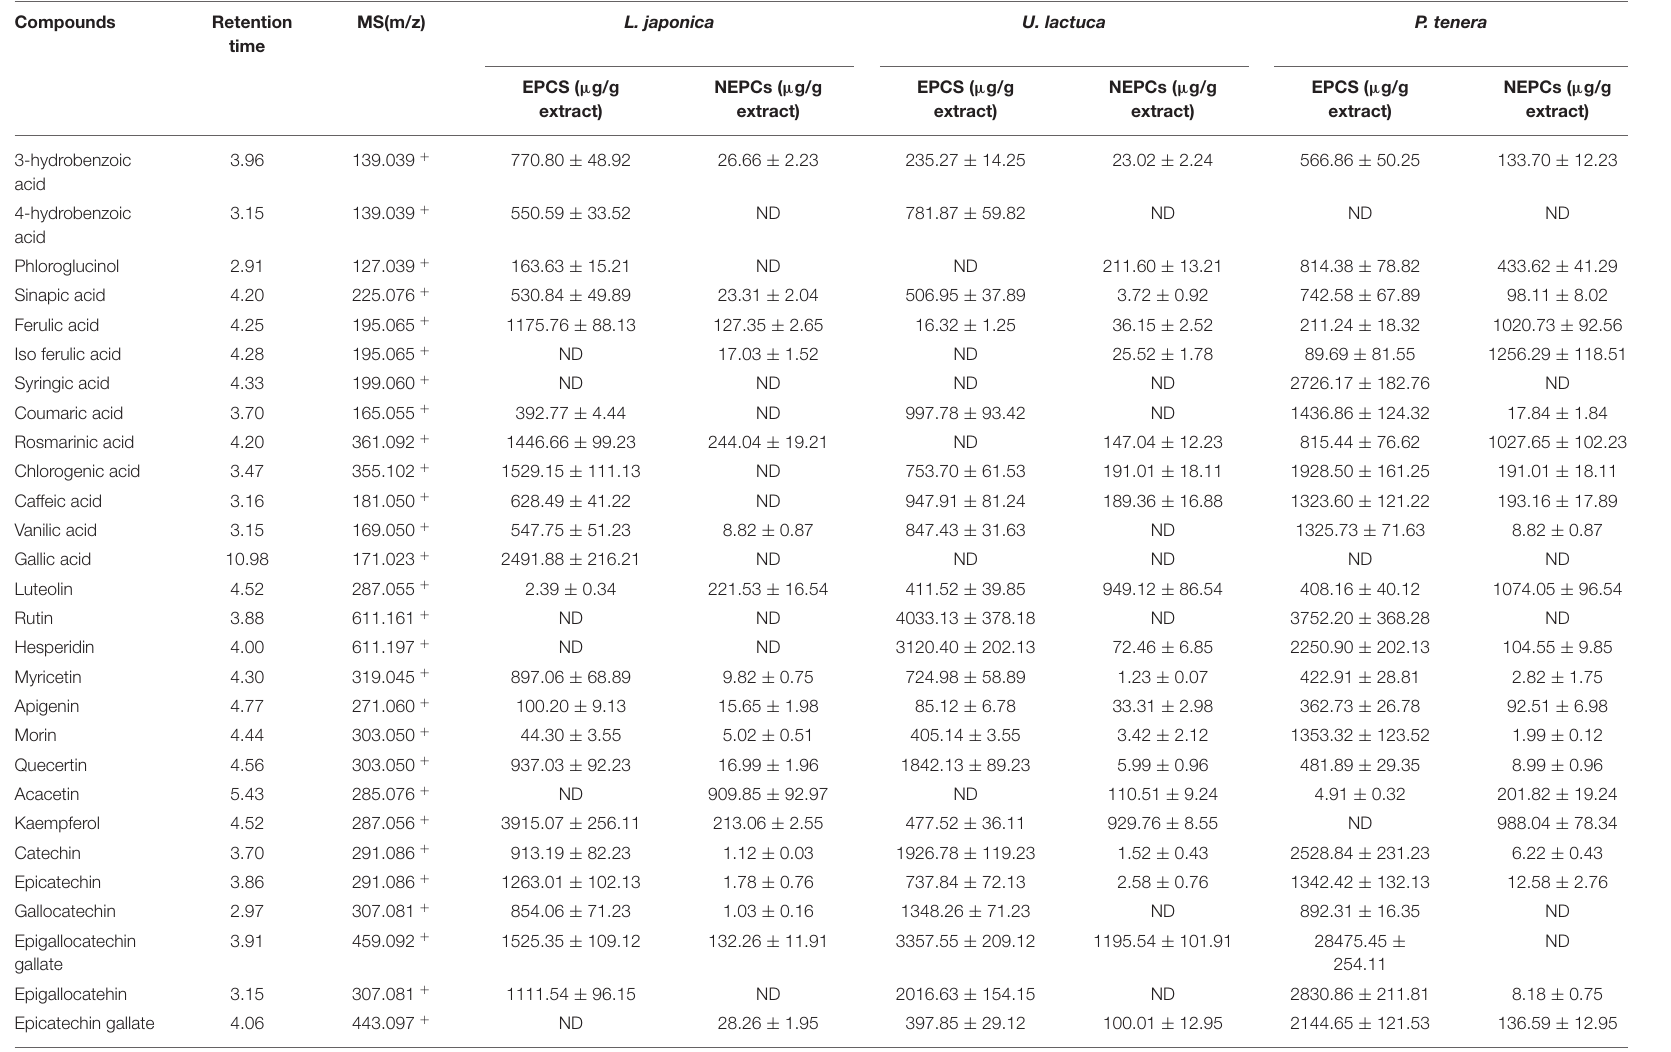
TABLE 1 | Selected phenolic compounds identified in the EPCs and NEPCs in L. japonica , U. lactuca , and P. tenera .